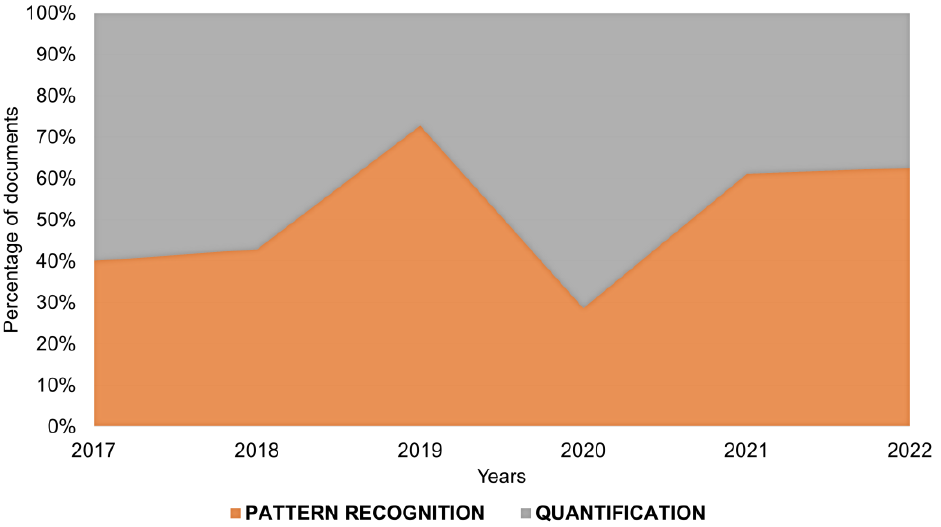
Figure 3. Percentage of publications about UV-Vis spectralprint approaches comparing pattern recognition and quantification applications in the last 6 years.